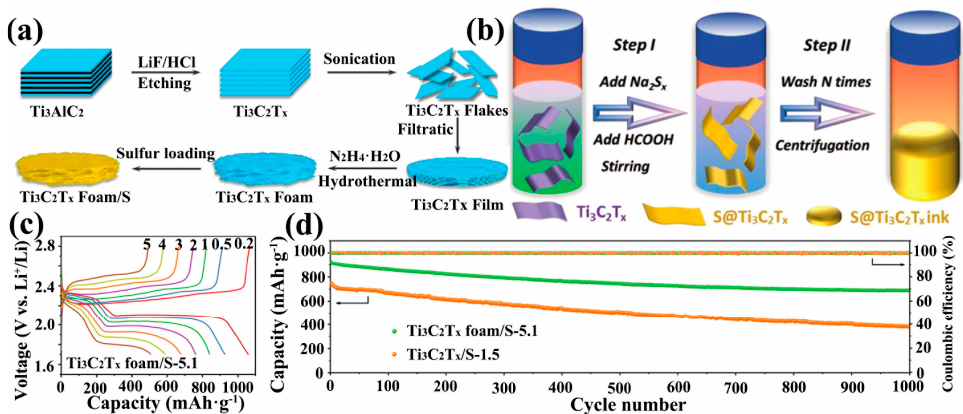
Figure 4. Synthesis of Ti 3 C 2 T x foam/S cathodes ( a ) and their corresponding cell-rate performance ( c ) and long-cycle performance ( d ) [89]. Copyright 2018, RSC Pub. ( b ) Synthesis of S@Ti 3 C 2 T x ink [90]. Copyright 2018, John Wiley and Sons.